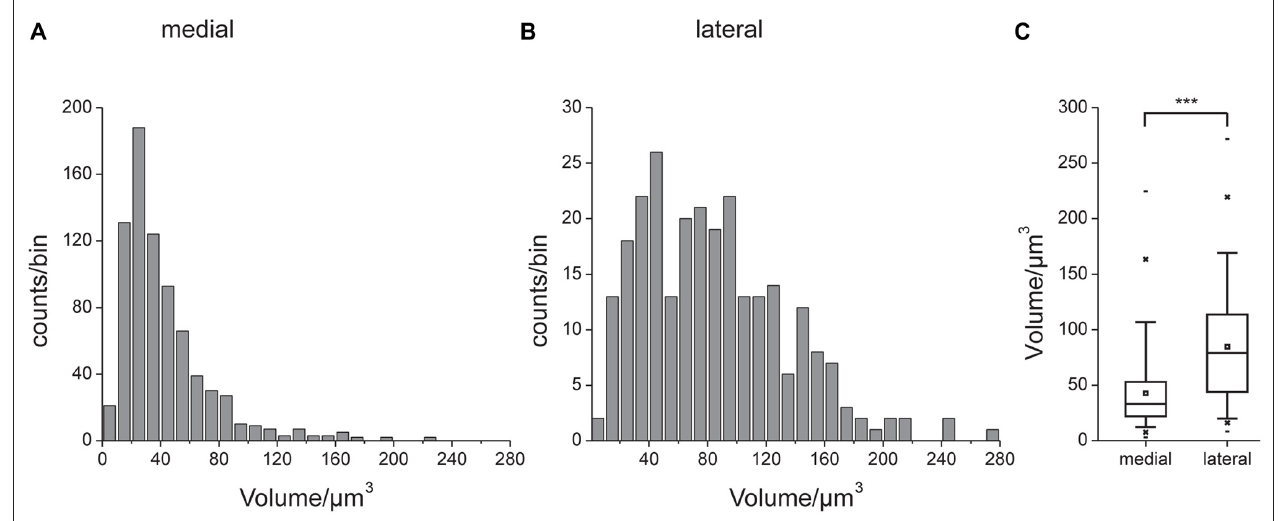
FIGURE 4 | Volumes of the reconstructed f-actin positive postsynaptic portion of the microglomeruli. Unilateral data from four brains. Histograms of data from the medial (A) and lateral (B) cluster. Note different scaling in (A,B) . (C) Comparison of volume data. Box: 25th, 50th and 75th percentile, small square: average, whiskers: 5th and 95th percentile, cross: 1st and 99th percentile, dash: minimum and maximum value. The median microglomerulus volume in the medial cluster was 33 µ m 3 , whereas it was 79 µ m 3 in the lateral cluster. This difference was statistically significant (indicated by ∗∗∗ , Mann-Whitney test, P < 0.0001, U = 157060.5, z = − 13.39, n = 4, N medial = 772, N lateral =